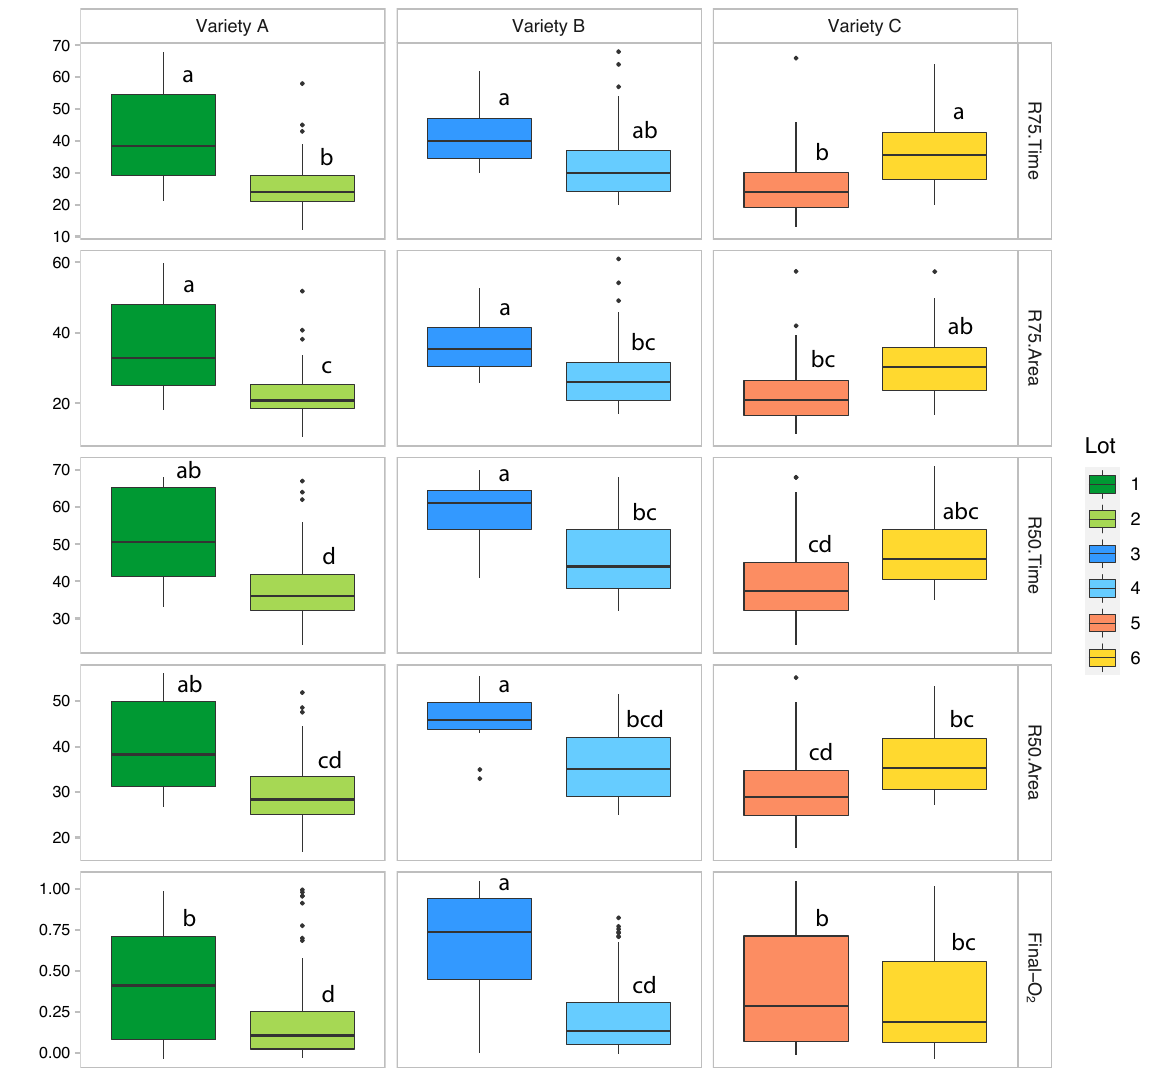
Figure 7. Selected Q2 parameters (see Table 1) of seed lots after blindness induction treatment. Letters indicate significance between all lots for each parameter (rows) as calculated by ANOVA and Tukey